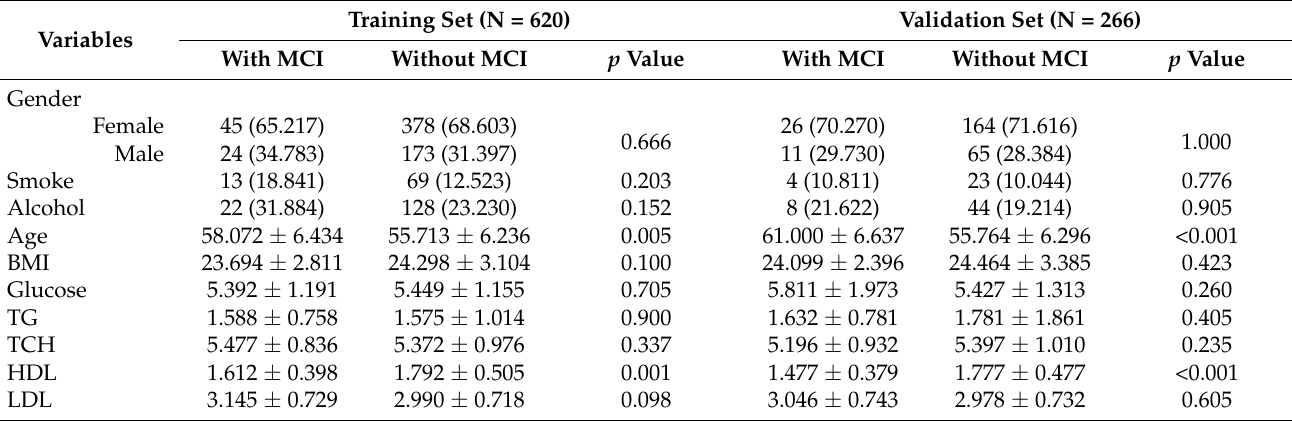
Table 1. The demographic and clinical baseline of the